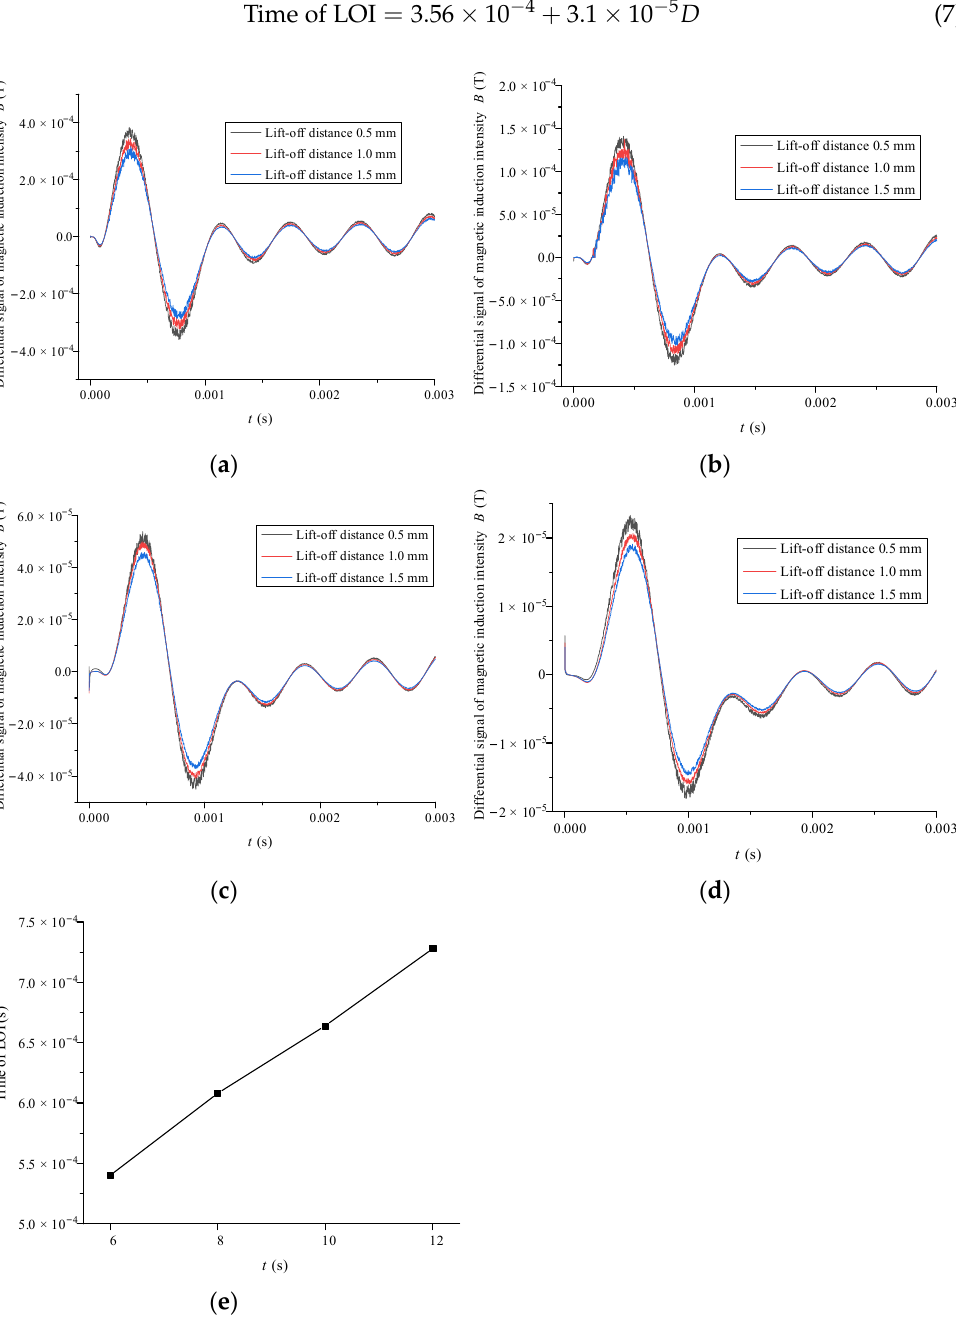
Figure 7. Differential pickup signals of magnetic induction intensity under different lift-off distances: ( a ) 6 mm defect depth, ( b ) 8 mm defect depth, ( c ) 10 mm defect depth, ( d ) 12 mm defect depth; ( e ) variations in time of LOI with defect depths.